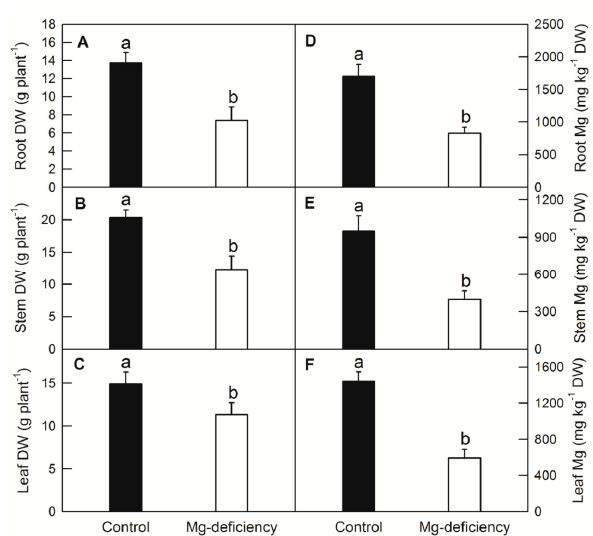
Figure 2. E ff ects of Mg deficiency on plant dry weight (DW; root, ( A ); stem, ( B ); shoot, ( C )) and Mg Figure 2. Effects of Mg deficiency on plant dry weight (DW; root, A ; stem, B ; shoot, C ) and Mg content (root, ( D ); stem, ( E ); leaf, ( F )) in C. sinensis seedlings. Bars represent means ± SD ( n = 5 for content (root, D ; stem, E ; leaf, F ) in C. sinensis seedlings. Bars represent means ±SD ( n = 5 for Mg Mg content or 10 for plant DW). Di ff erence among the treatments was analyzed by student’s t -test. Int. J. Mol. Sci. 2019 , 19 , x content or 10 for plant DW). Difference among the treatments was analyzed by student’s t -test. Di ff erent letters indicate a significant di ff erence at p < 0.05. Different letters indicate a significant difference at p < 0.05.